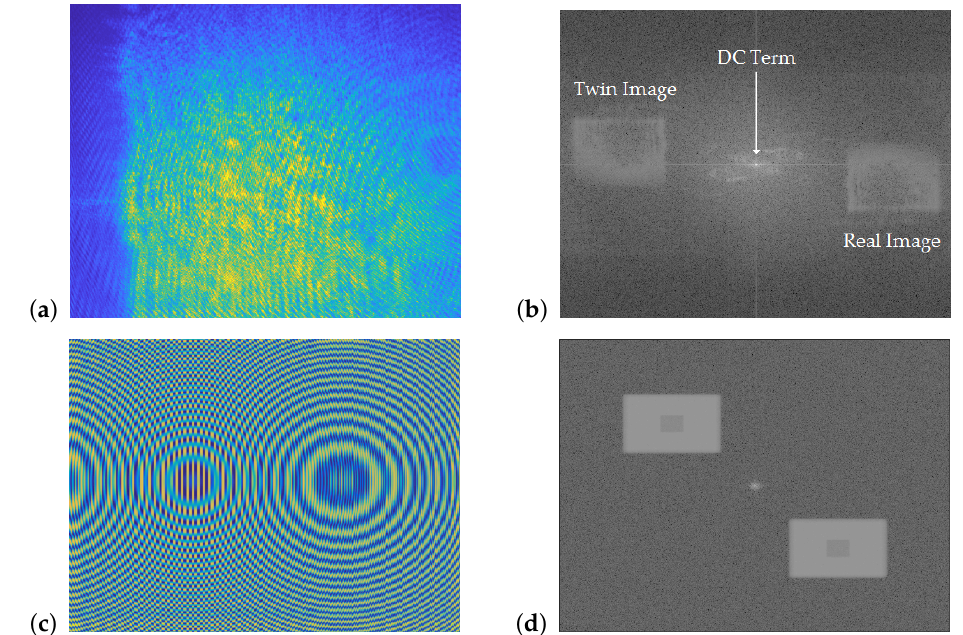
Figure 7. Comparison of experimentally derived and simulated holograms and interferograms. ( a ) Experimentally-derived hologram. ( b ) Interferogram reconstructed from ( a ). ( c ) Simulated hologram. ( d ) Interferogram reconstructed from ( c ).